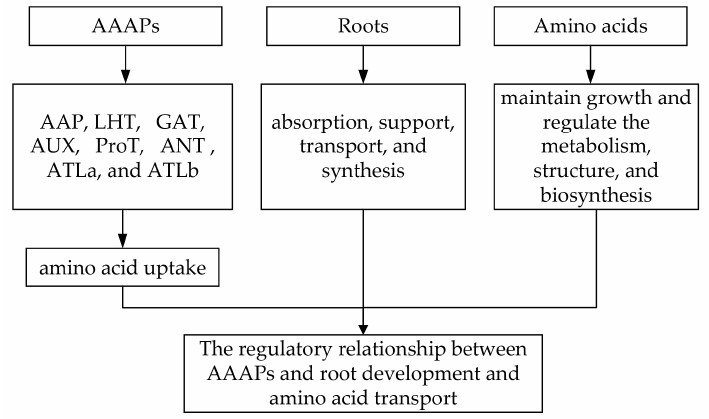
Figure 1. Research status and prospect of AAAPs, roots, and amino acids.